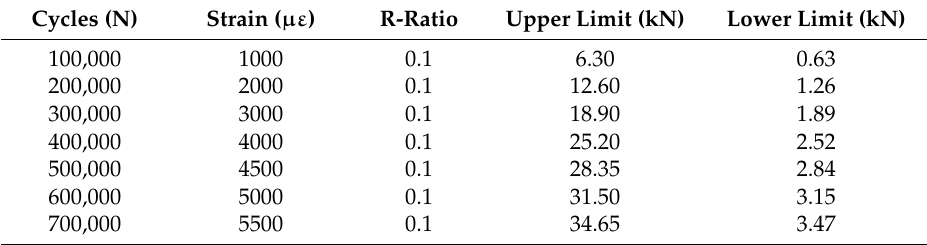
Figure 5. Experimental setup of the composite specimen on testing machine with the red dotted line indicating the bonded fibre. The bonded fibre along the region of interest was labelled as Fibre 1 ( left ) and Fibre 2 ( right ). Table 3. Block loading regime—strain amplitude increased every 10 5 cycles starting at 1000 µε